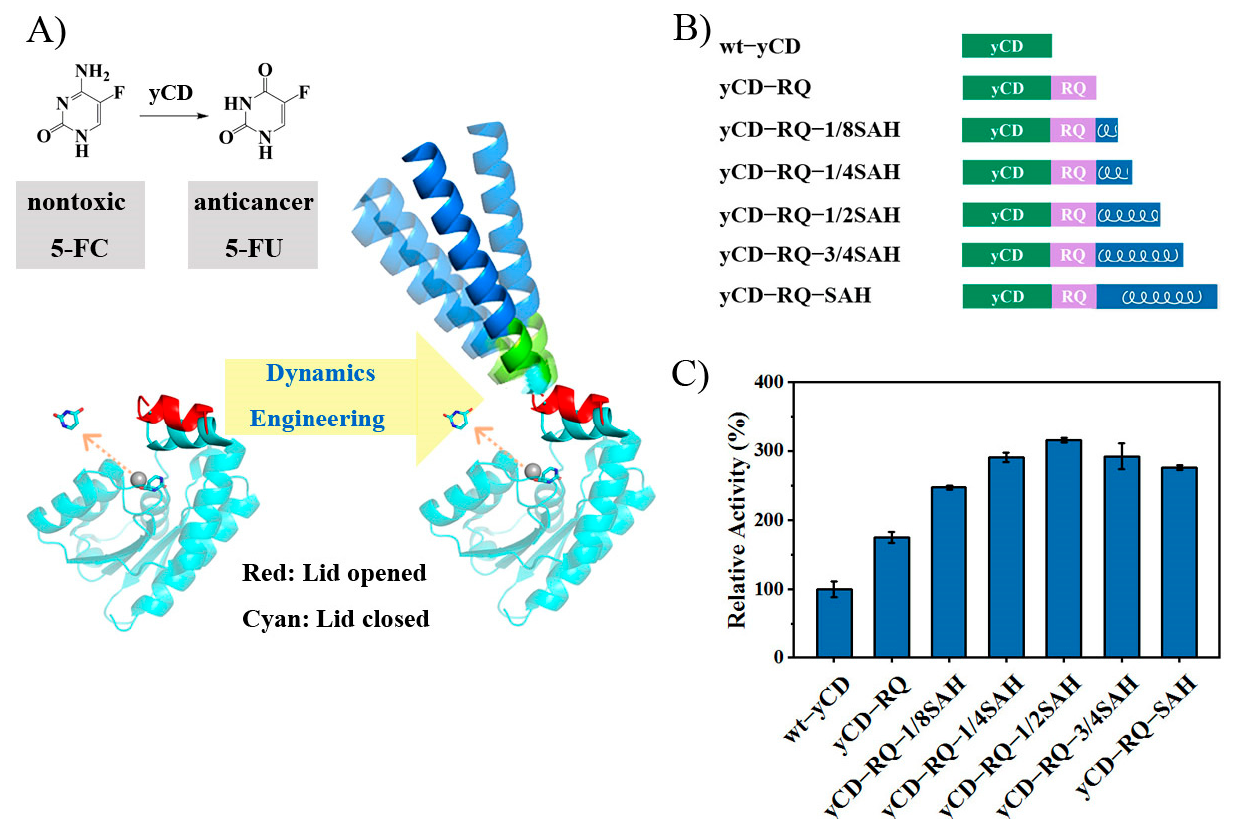
Figure 1. Constructs of yCD variants and their relative activity. ( A ) Schematic drawing of the strategy to accelerate the yCD catalysis (5-FC to 5-FU) by engineering the dynamics of the C-terminal helix (which controls the rate-limiting product release) through the helix extension with a single α -helix SAH. The dynamics of SAH may enhance the dynamics of the C-terminal helix. ( B ) yCD constructs with the SAH helix (or its part) and a linker RQ (composed of five residues) in between. ( C ) Relative catalytic activity against 5-FC, with the wt-yCD activity set to 100%. The reaction mixture contained 10 mM 5-FC and 0.05 µ M yCD in a buffer of 20 mM Tris and 100 mM NaCl, pH 7.0. The reactions were carried out at 303 K in triplicate. The error bars are the standard deviation.